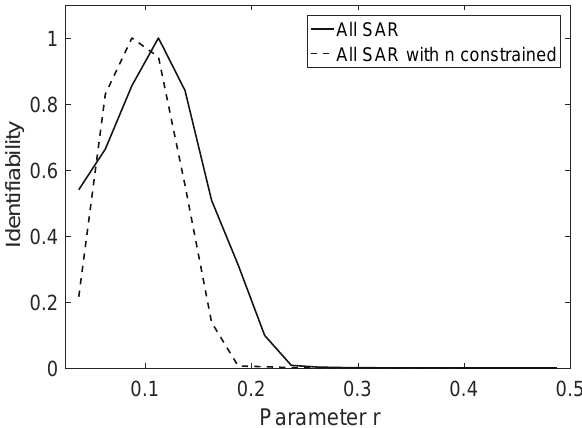
Figure 9. Identifiability for 23 July 2007 at 10:27GMT showing all data (solid line) and with n c restricted to between 0.035 and 0.055 (dashed